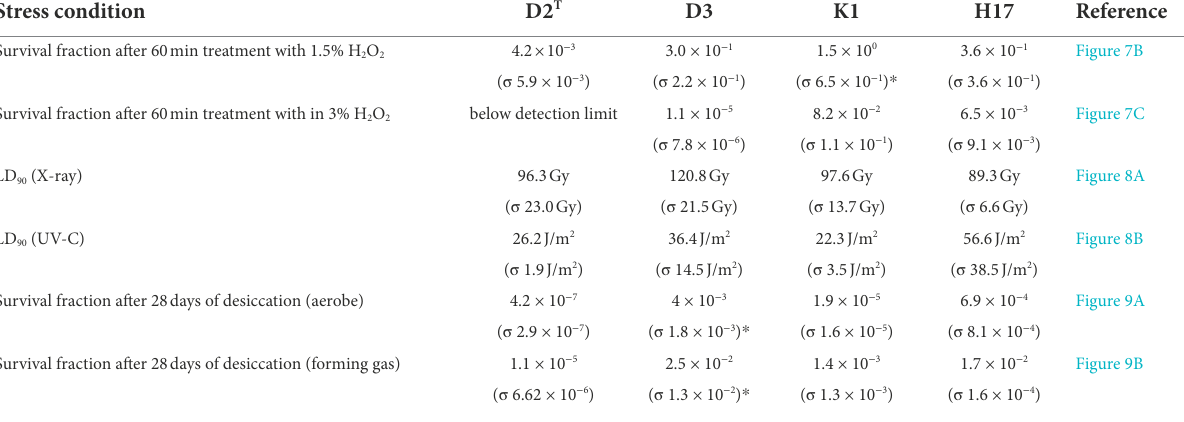
TABLE 5 Survival of S. capitis strains in different stress